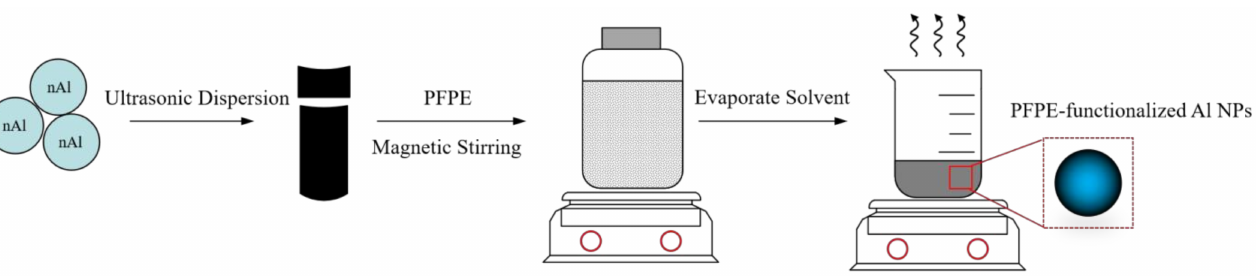
Figure 1. Schematic description of the fabrication of PFPE-functionalized Al